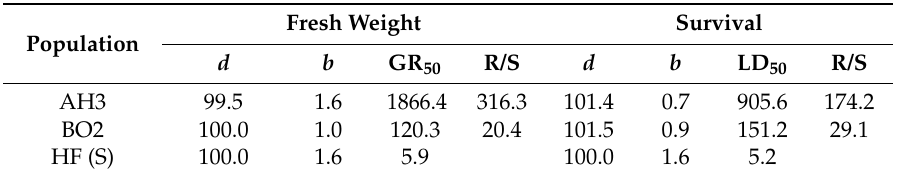
Table 1. Clodinafop-propargyl doses (g ai ha − 1 ) needed to reduce the fresh weight (GR 50 ) and survival percentage (LD 50 ) by 50% in Lolium rigidum biotypes from